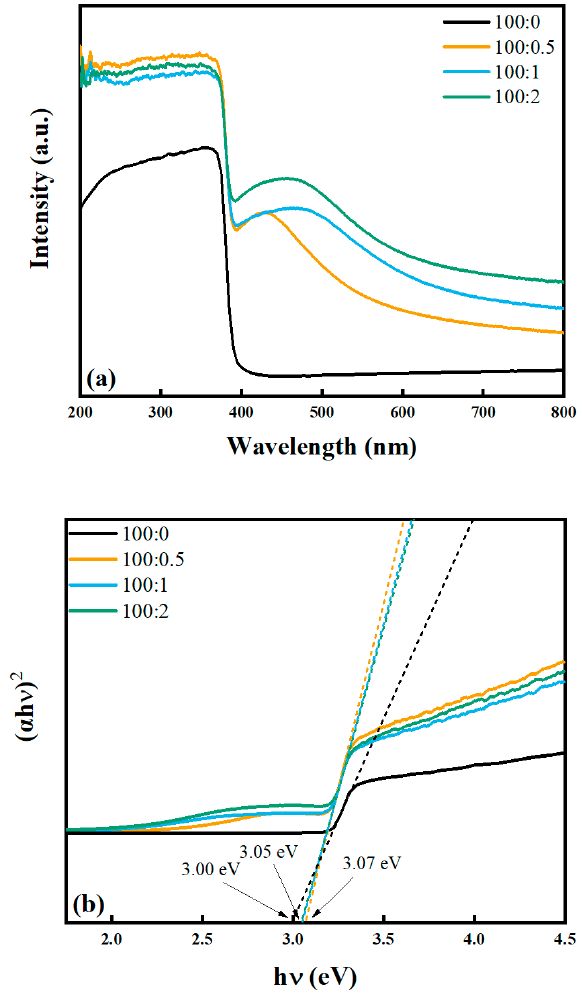
Figure 4. ( a ) UV-vis spectra and ( b ) plots of ( α h ν ) 2 versus energy (h ν ) of all prepared photocatalysts Ag/ZnO.